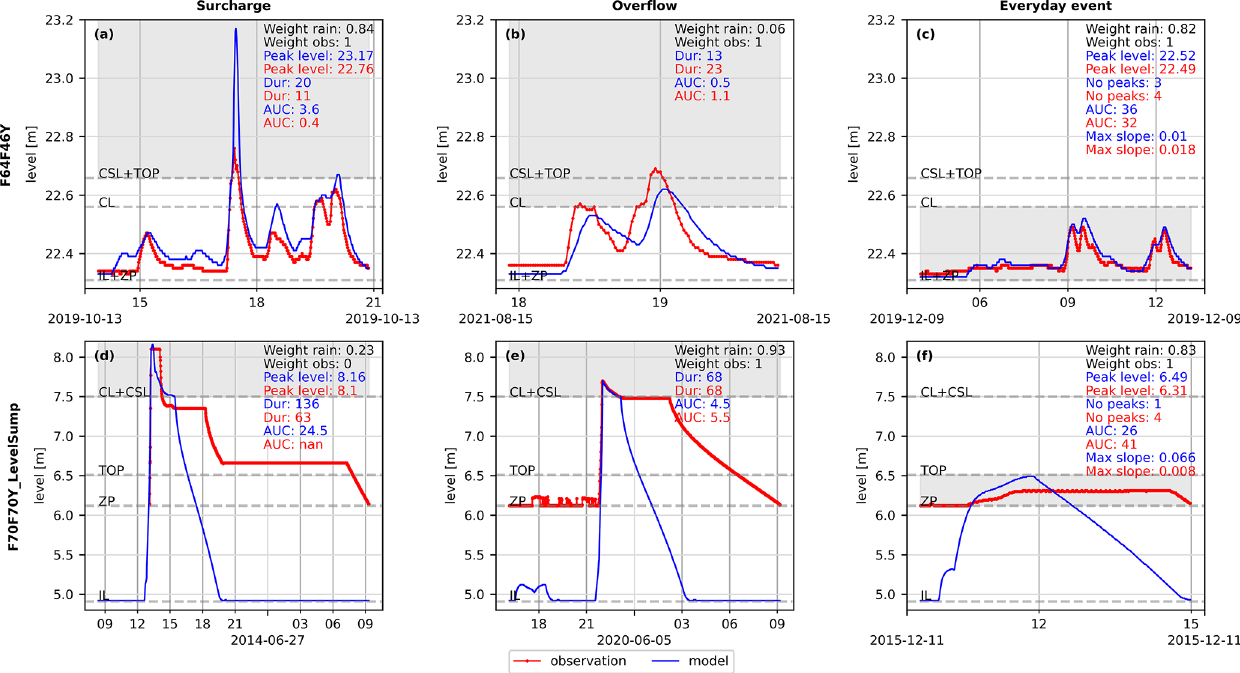
Figure 8. Examples of time series plotted for two sites (rows). F64F46Y (a–c) and F70F70Y_LevelSump (d–f) . The objectives are illustrated in the columns as surcharge, overflow, and everyday events, respectively. The values indicated in the top right-hand corner of each subplot indicate the values of the signatures for the three objectives for the modelled event (blue) and the observed event (red). The weights of the rain gauge uncertainty are indicated, in addition to the weight obs., which is a combination of the weights from known system anomalies and indications of whether the sensor reached an upper